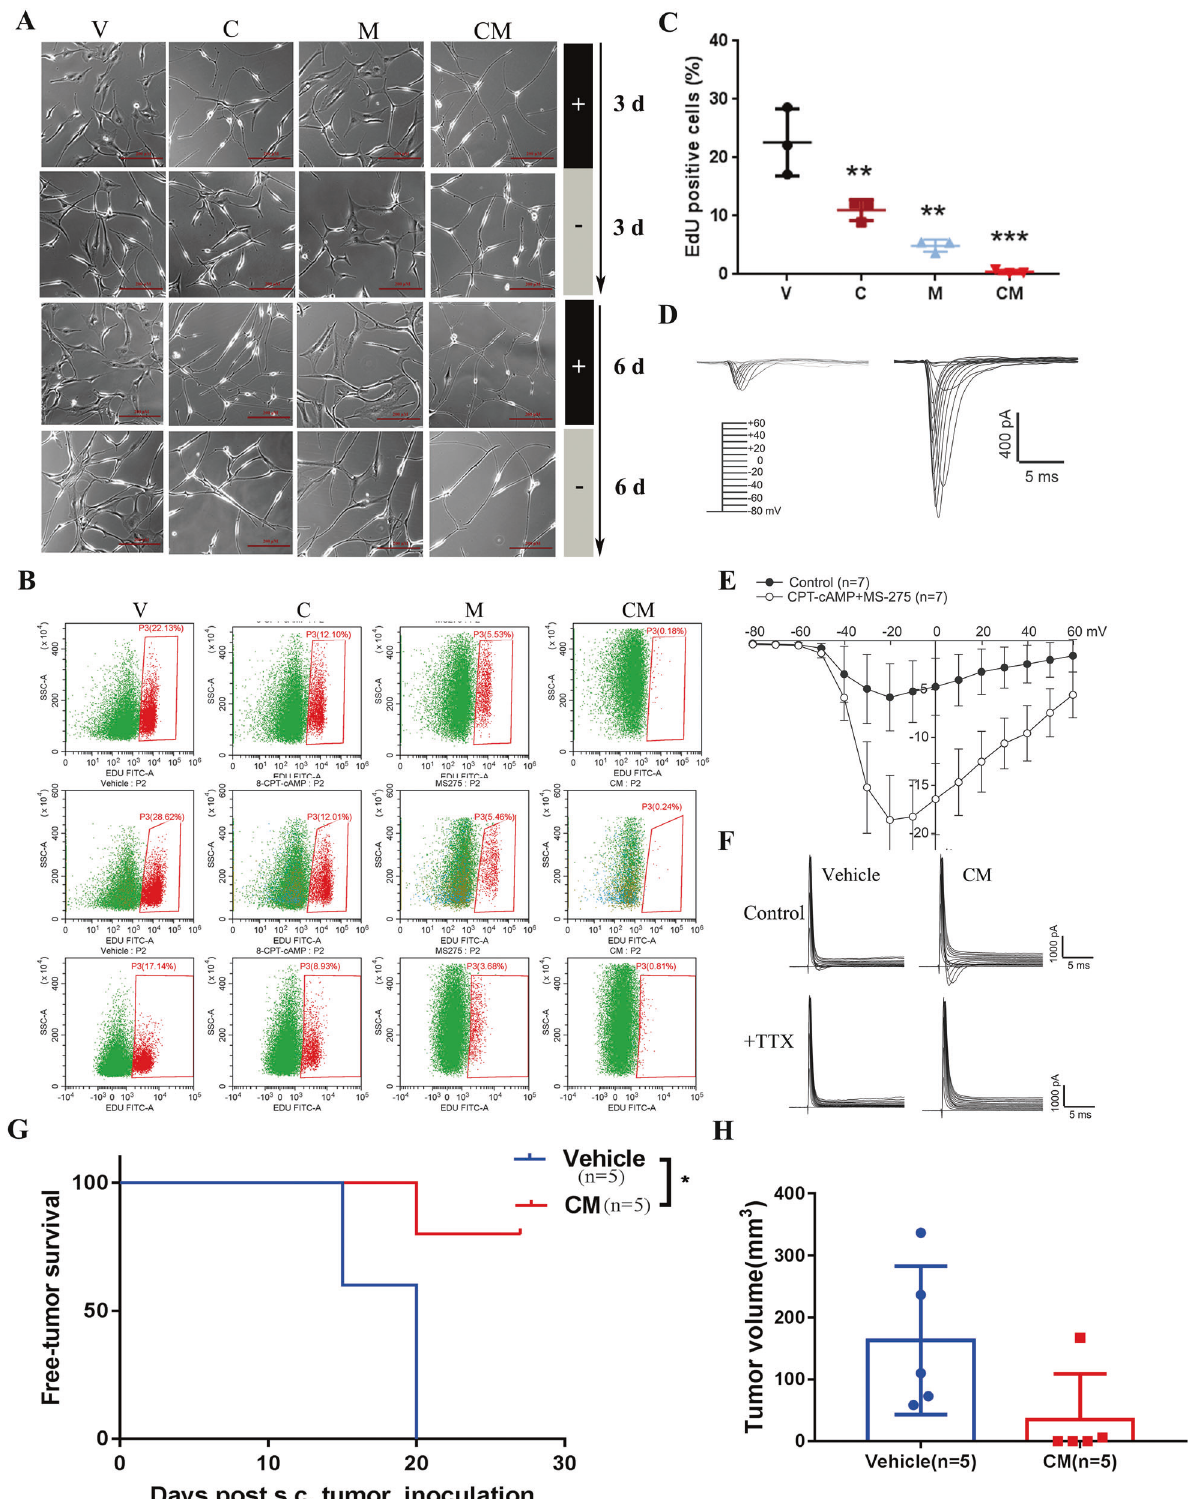
found that a high single sample GSEA score of H3K9ac were strongly related with high WHO grade and low survival probability, while the opposite was observed for H3K14ac (Fig. 5E – H). Furthermore, we de fi ned an integrated score for all 693 patients by simply using the score of H3K9ac minus one of H3K14ac, which we called the H3K9/ K14 score. As expected, the integrated score increased along with Cell Death and Disease (2023)